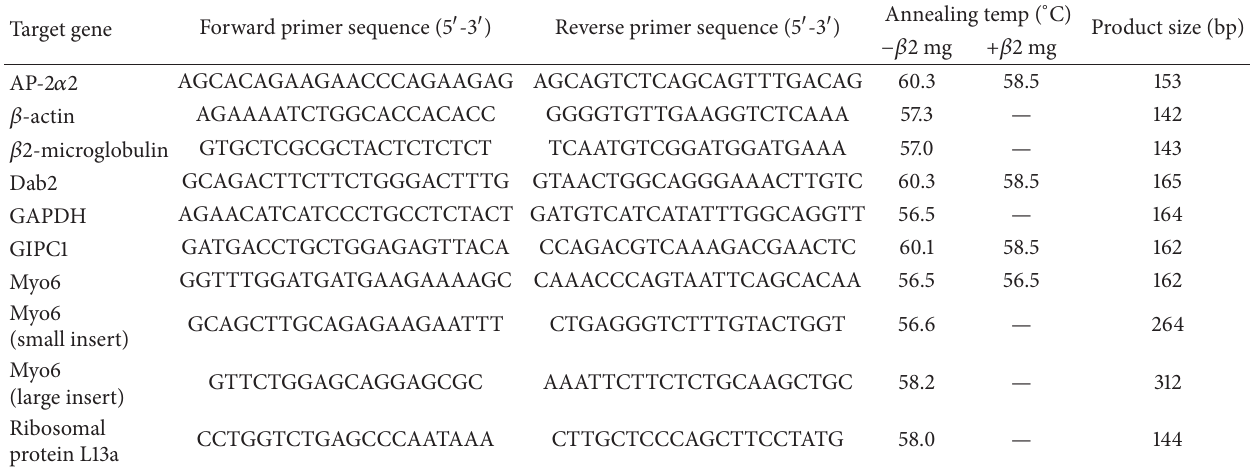
Table 1: Primers, annealing temperatures, and product sizes for PCR. 𝛽 2 mg, 𝛽 2 microglobulin.